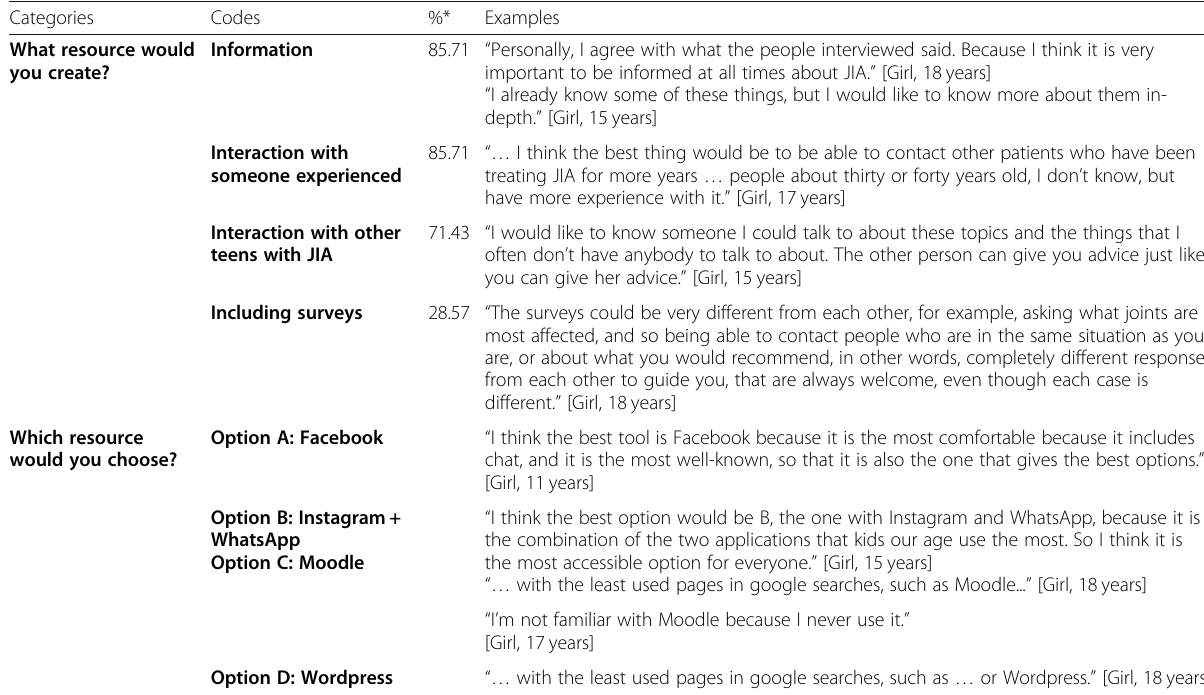
Table 5 Categories and codes identified (focus group)